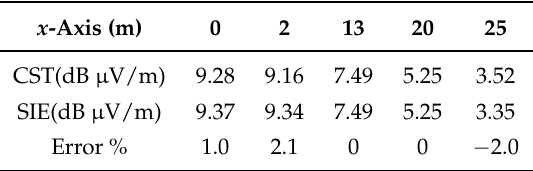
Table 2. The total electric field at test point ( x ,0, − 60 ) .